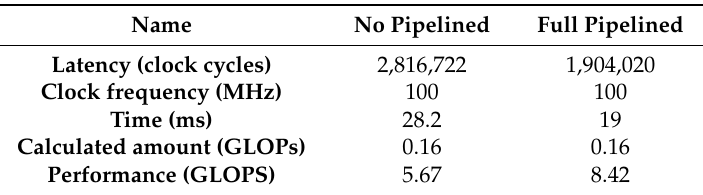
Table 5. Comparisons of the second